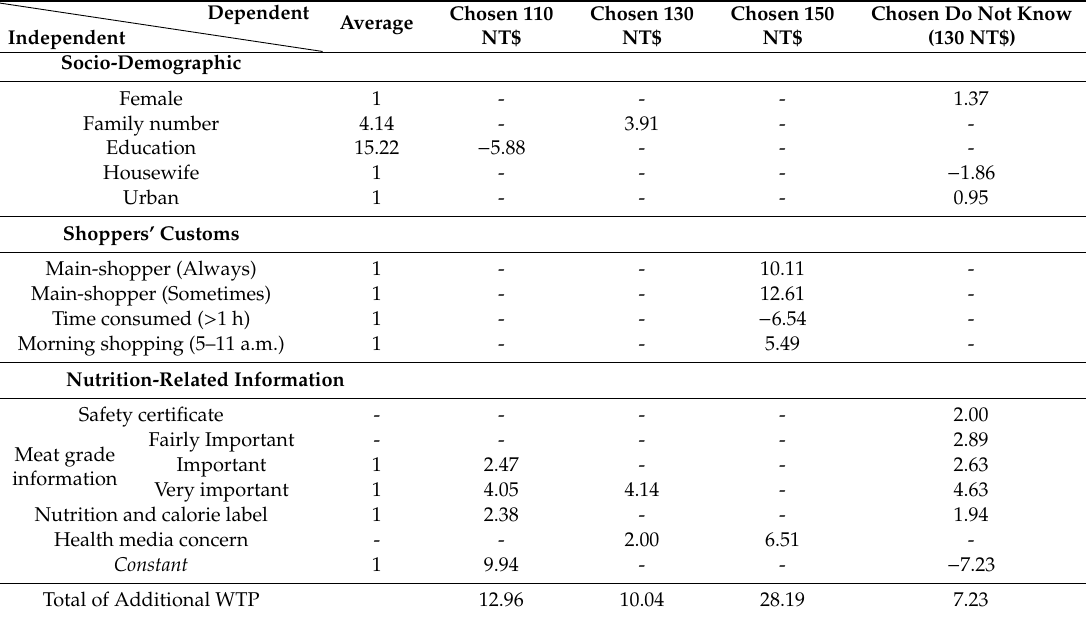
Table 4. The estimation of additional WTP for nutrition